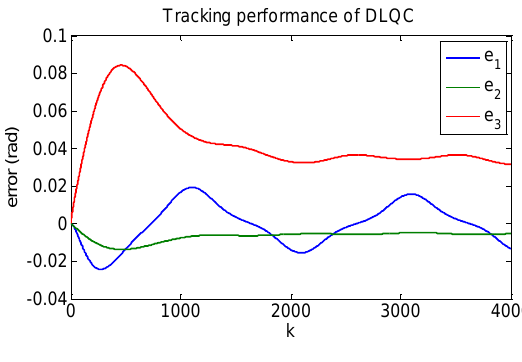
Figure 8. Tracking performance of DLQC.